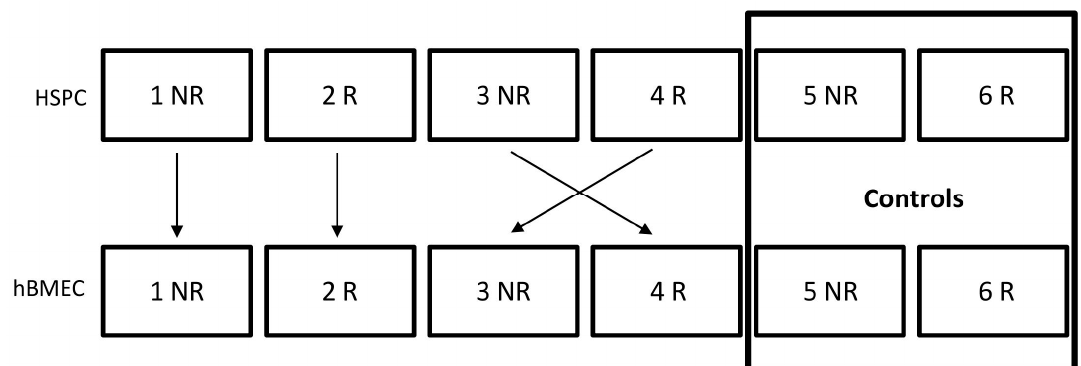
Figure 10 Coculture Strategy. R = irradiated; NR = nonirradiated.